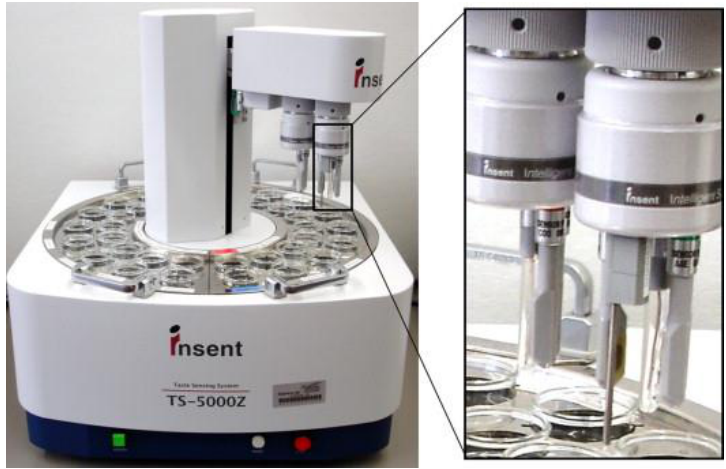
Figure 2. TS-5000Z taste sensing system, Intelligent Sensor Technology Inc., Japan. Reprinted with permission from [43] © Elsevier).